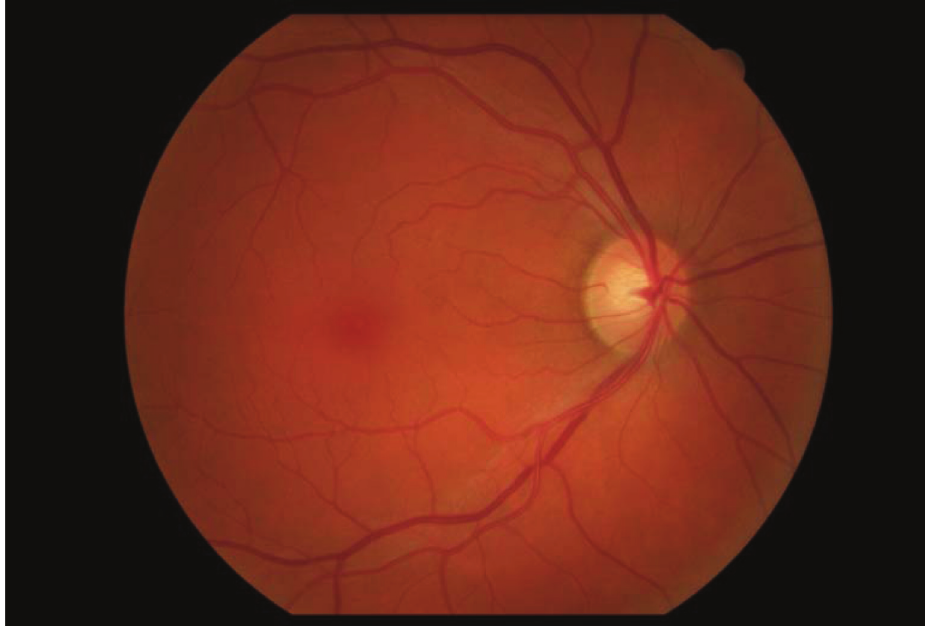
Figure 1: Colour fundus photograph of right eye in February 2005. No indications of retinal disease were present.